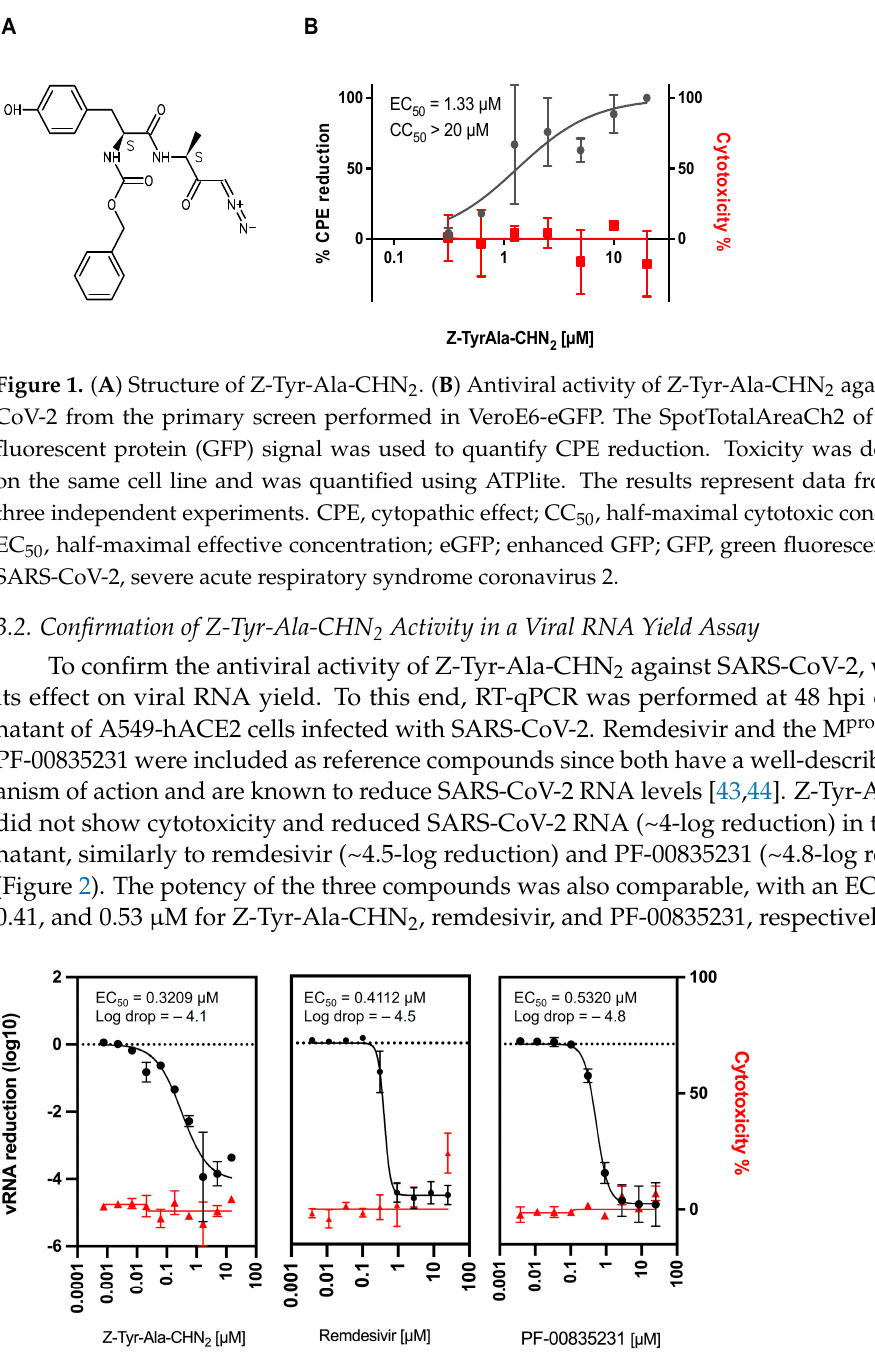
Figure 3. Antiviral activity of Z-Tyr-Ala-CHN 2 against SARS-CoV-1 (black, full circles) in A549- hACE2 and against HCoV-229E (black, empty squares) in HeLa-hACE2. Infection of SARS-CoV-1 was detected using an anti-spike antibody, whereas infection against HCoV-229E was detected us- ing an anti-dsRNA antibody. The mean ± SD values are shown from two to three independent ex- periments. Cytotoxicity determined in uninfected A549-hACE2 using ATPlite (red, full triangles) represents the mean ± SD of two independent experiments. HCoV-229E, human coronavirus 229E; SD, standard deviation; SI, selectivity index. 0.0001 0.01